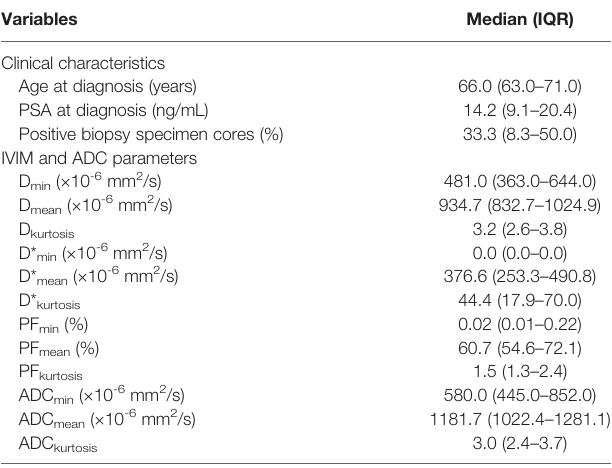
TABLE 2 | ISUP grades of prostate cancers obtained before radical prostatectomy (RP) and using histological results of the RP specimens of the 45 patients.